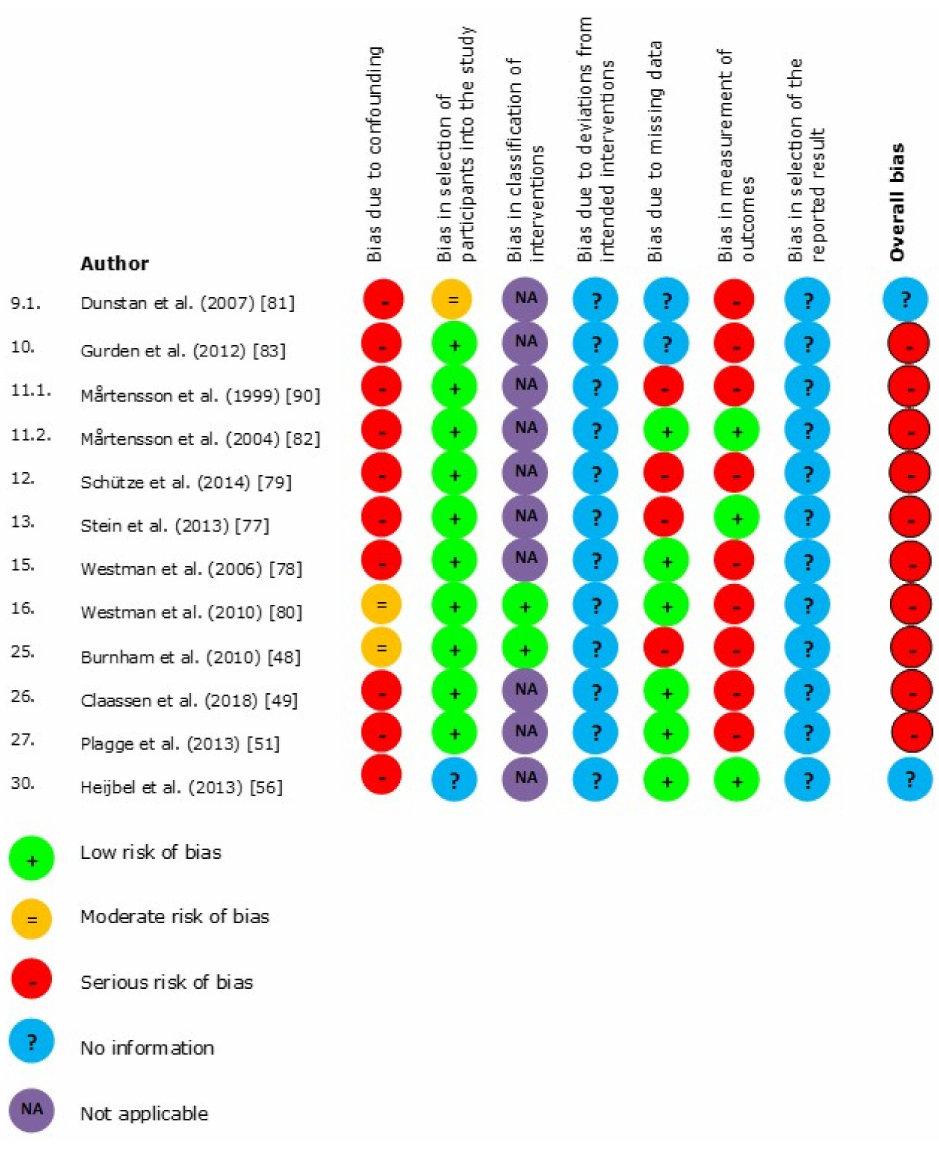
Figure 4. Risk of bias of non-randomized study designs.